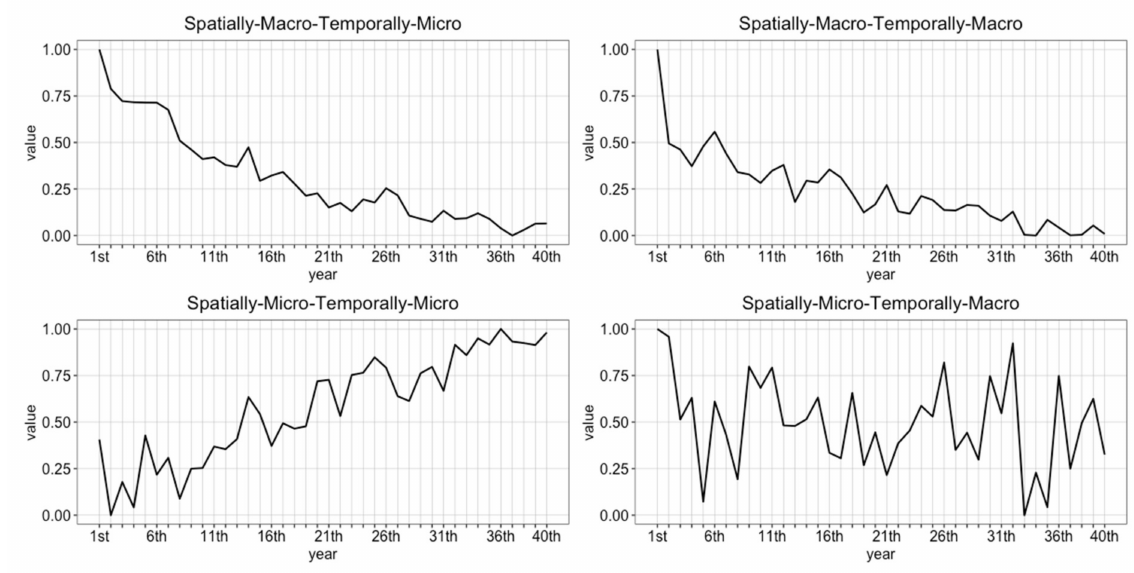
Figure 10. Normalized CV of each pattern over simulation year. Simply using the average of normalized CVs indicates that simulated outcomes after 9th simulation year became relatively stable. However, it may also be problematic. After 32th simulation year, the simulated outcomes became flexible again (Figure 11).